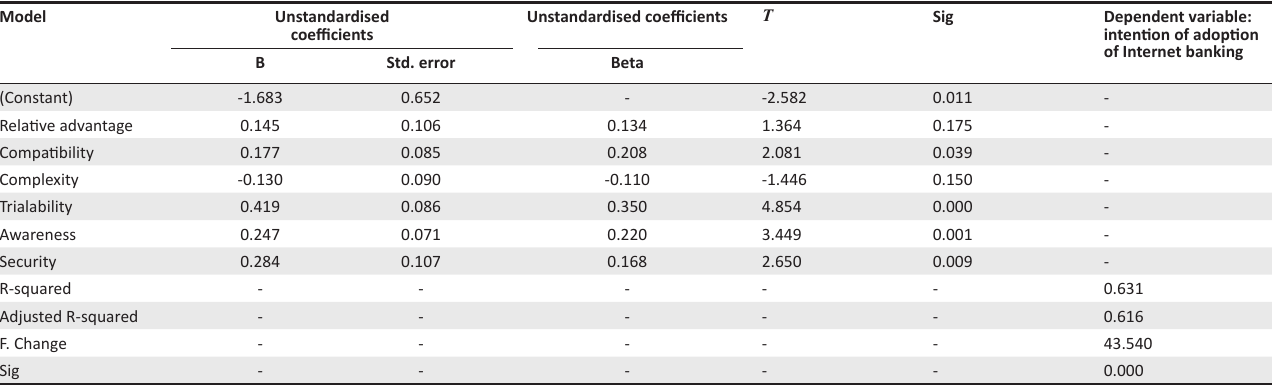
TABLE 3: Results of regression analysis model in the study. Model